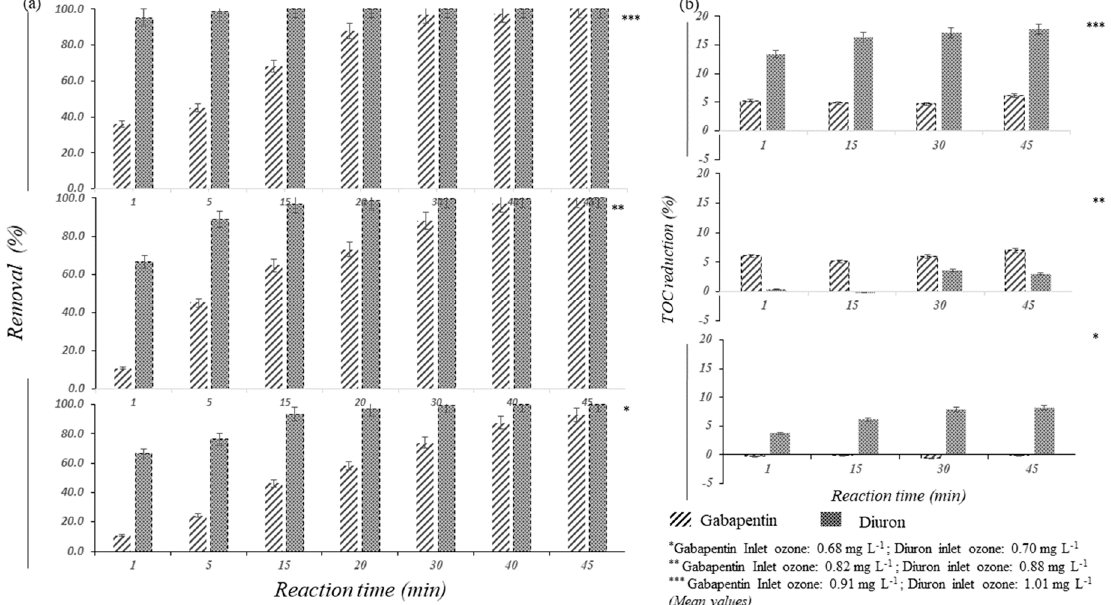
Figure 2. Ozonised gabapentin and diuron solution ( a ) percentage removal; ( b ) TOC reduction. (Non-detectable gabapentin and diuron after ozonation of Lake Constance water for same the operating conditions as stated in the study